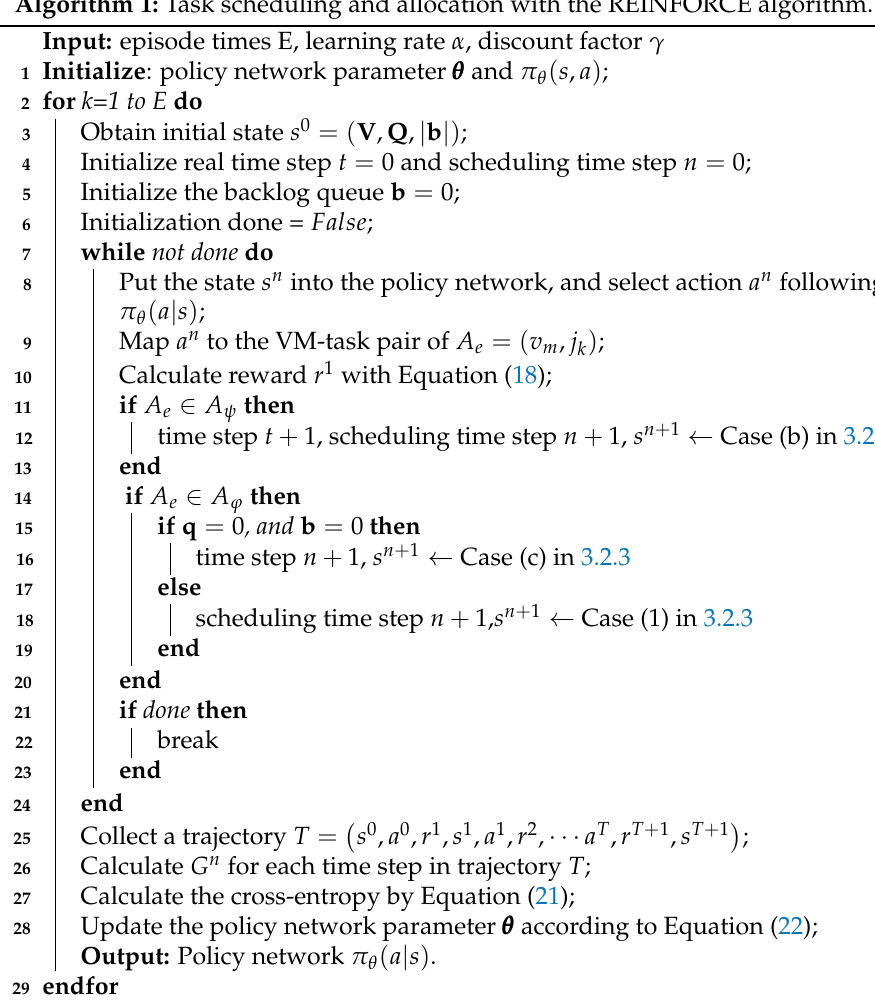
Algorithm 1: Task scheduling and allocation with the REINFORCE